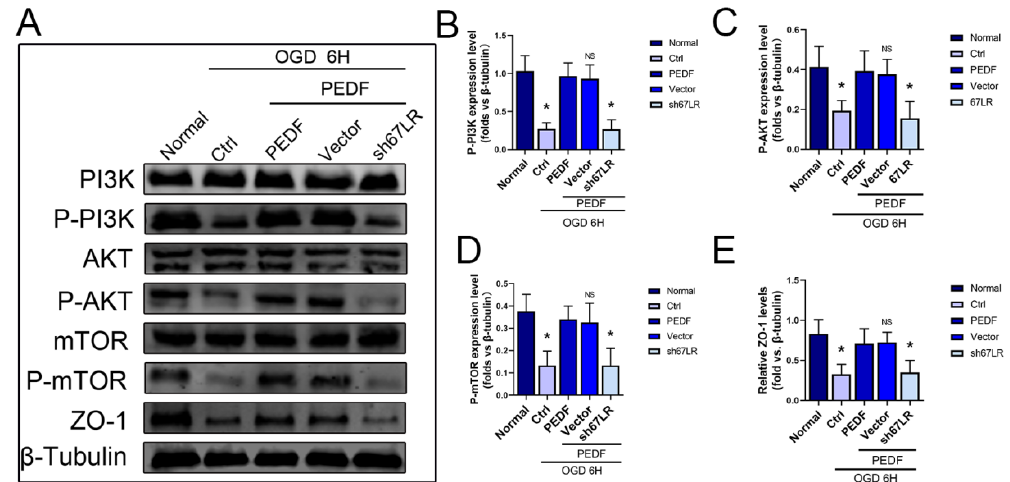
Figure 5. PEDF regulates the PI3K-AKT-mTOR pathway and ZO-1 expression through 67LR. ( A ) Western blotting to detect the effect of PEDF on phospho-PI3K, phospho-AKT, phospho-mTOR, and ZO-1 expressions. ( B – E ) Quantification of the related protein expressions. Data are expressed as mean ± SD; n = 4; NS, no significant difference; * p < 0.05.